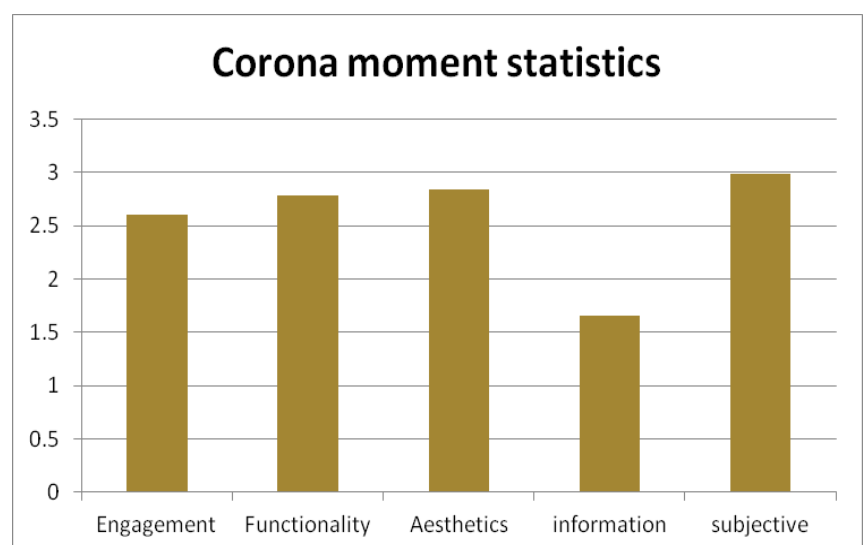
Fig 7. The evaluation of indicators in Corona moment statistics according to MARS